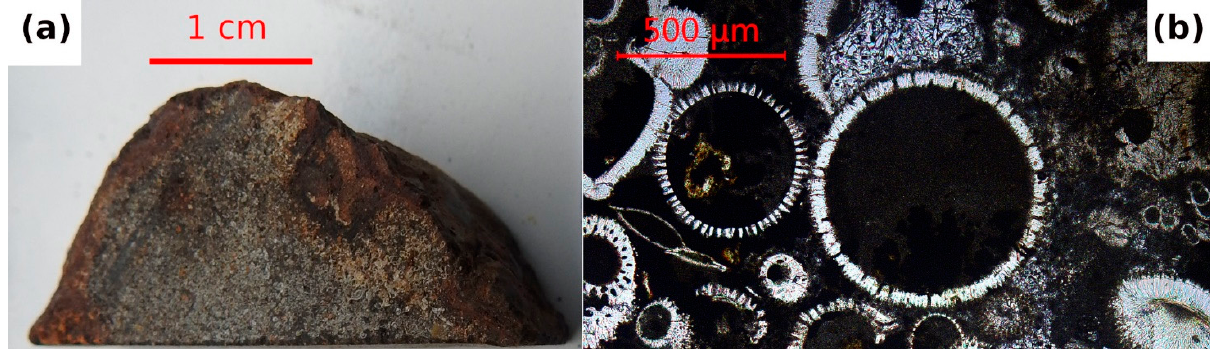
Figure 10. ( a ) A slice of authigenic carbonate nodule, sampled from the surface of H110 (processed and analyzed in SCISO). Along with calcite, the constituent minerals of the nodule contain illite, kaolinite, and chlorite, reflecting sources from deep substrates; ( b ) a microscopic thin section view of ( a ), showing rich biological fossils, which are unidentified.